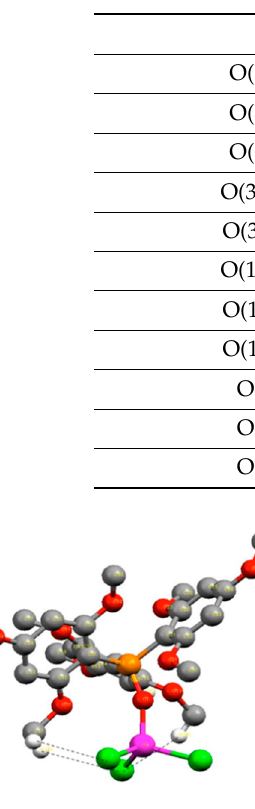
Figure 6. Intramolecular hydrogen bonding of three structures as listed in Table